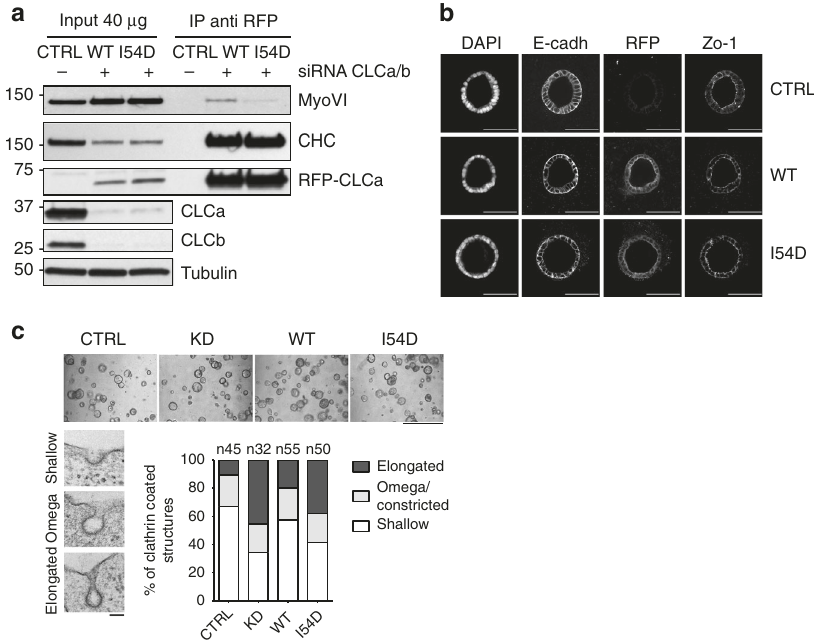
Fig. 5 CLCa I54D is a selective myosin VI-impaired mutant. a Co-immunoprecipitation experiment using lysates from Caco-2 reconstituted cell lines. Cells depleted of endogenous CLCs or mock treated are kept in con fl uency for 7 days, lysed, and RFP-CLCa wild-type and I54D were immunoprecipitated from 1 mg of lysates. IP and IB as indicated. b Representative confocal micrographs of CLCa wild-type and I54D localization in Caco-2 cysts. Staining with the indicated apical – basal polarity markers are shown. Scale bar, 100 µ m. c Upper panel, representative bright fi eld pictures of Caco-2 cysts generated using the indicated isogenic cell lines. Scale bar, 1 mm. Clathrin-coated structures present at the apical surface of the Caco-2 cysts were counted and classi fi ed as shallow, omega/constricted, or elongated according to their morphology. Left panel, representative EM images of the different morphology of CCPs. Scale bar, 100 nm. Right panel, distribution of clathrin-coated structures in the different isogenic cell lines expressed as percentage among the different classes and calculated on three independent experiments. Between 94 and 125 cellular pro fi les of well-polarized cells for each line were imaged. Number of clathrin-coated structures counted in total are reported as n = x . See also Supplementary Fig.